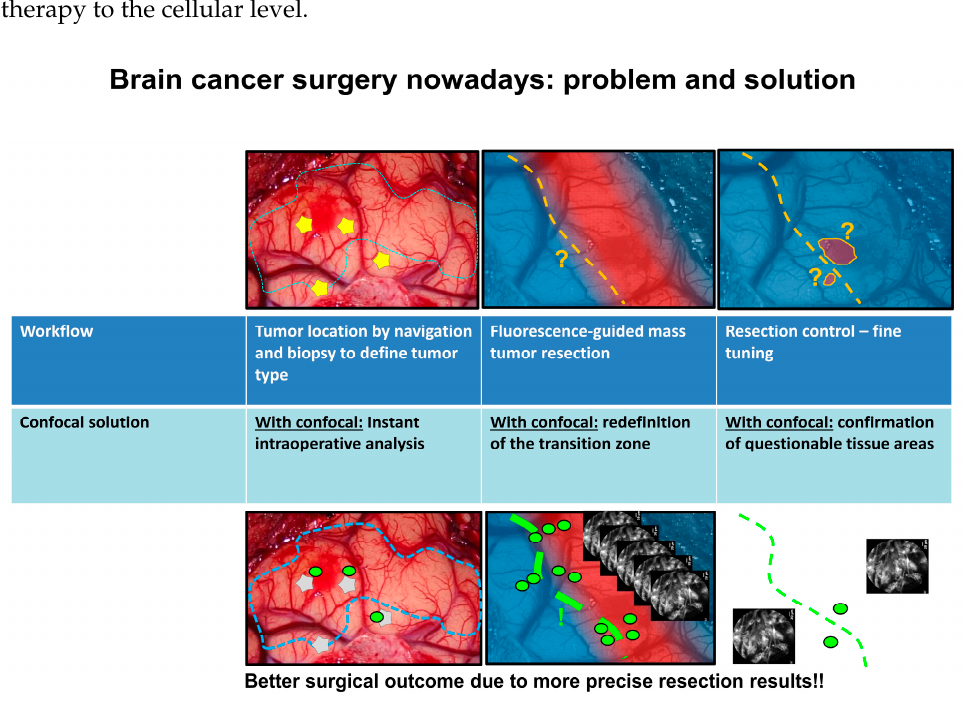
Figure 1. The problem faced in neurosurgical tumor treatment and how CLE could help to increase the intraoperative visualization perspectives. The green dots represent the confocal scanning. The lines show the resection borders.